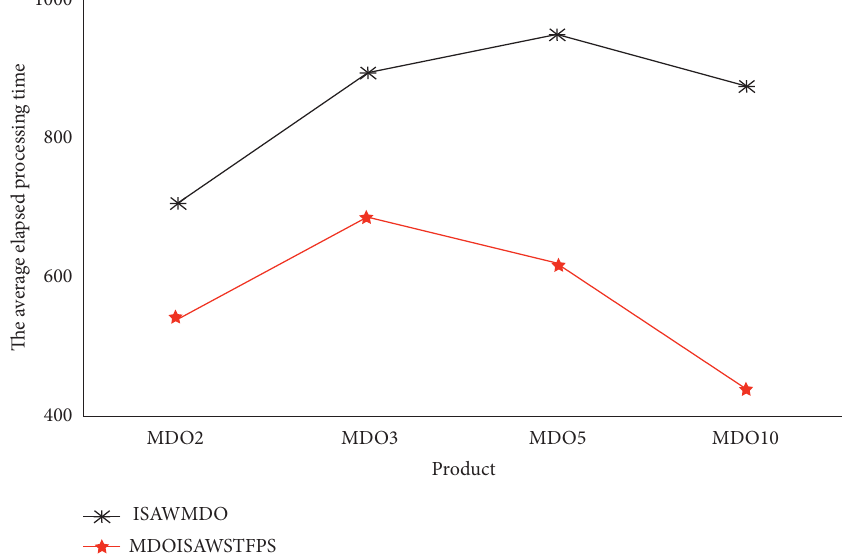
Figure 14: Comparison of the average elapsed processing time for the two